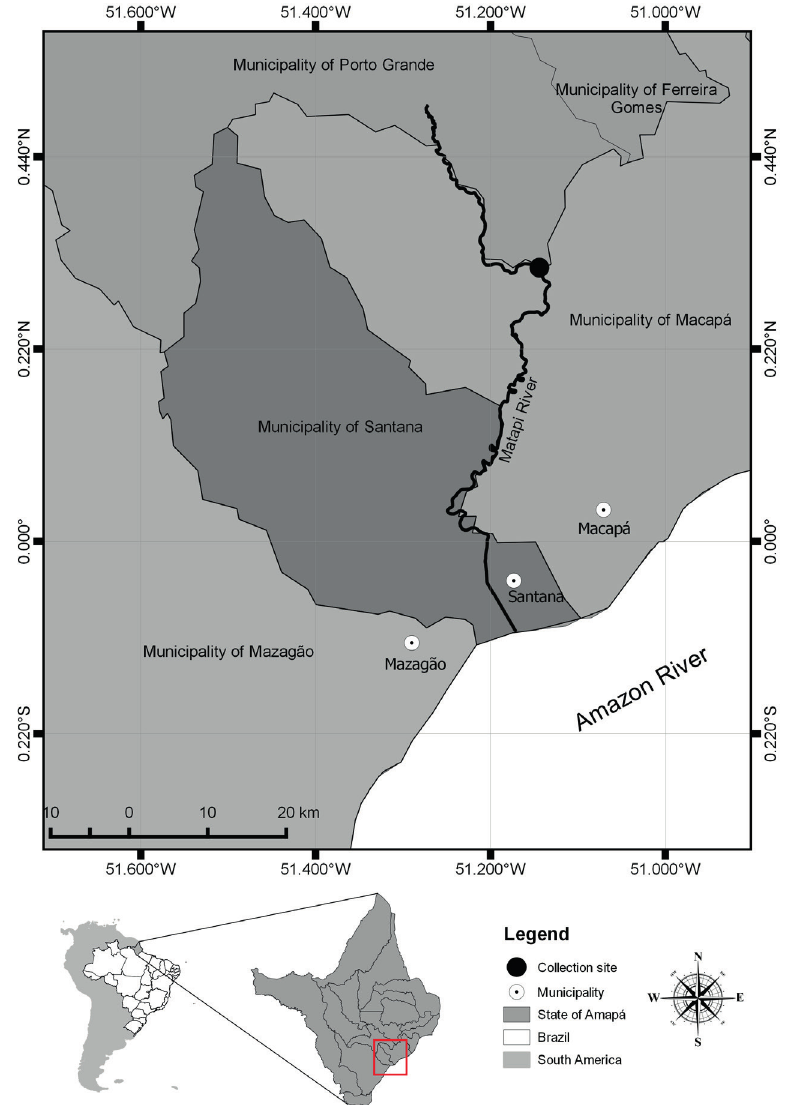
Figure 1 - Collection site of Hemibrycon surinamensis in the Matapi River, Amapá State,